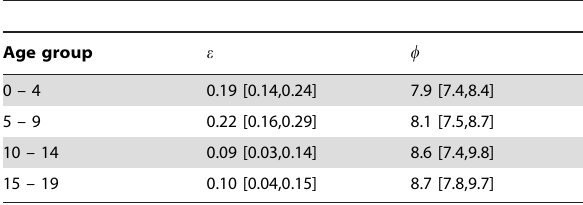
Table 1. Best-fit estimate and confidence interval for e (seasonality forcing) and w (phase of the seasonality, or where the peak of a period